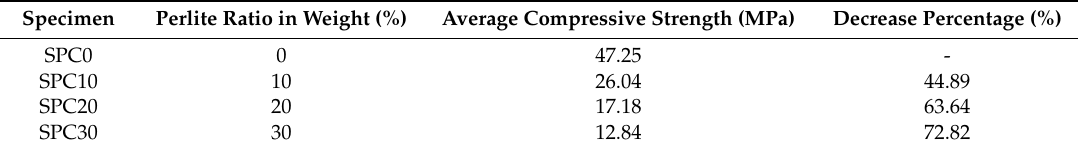
Table 9. Compressive strength test results of the perlite powder additive.